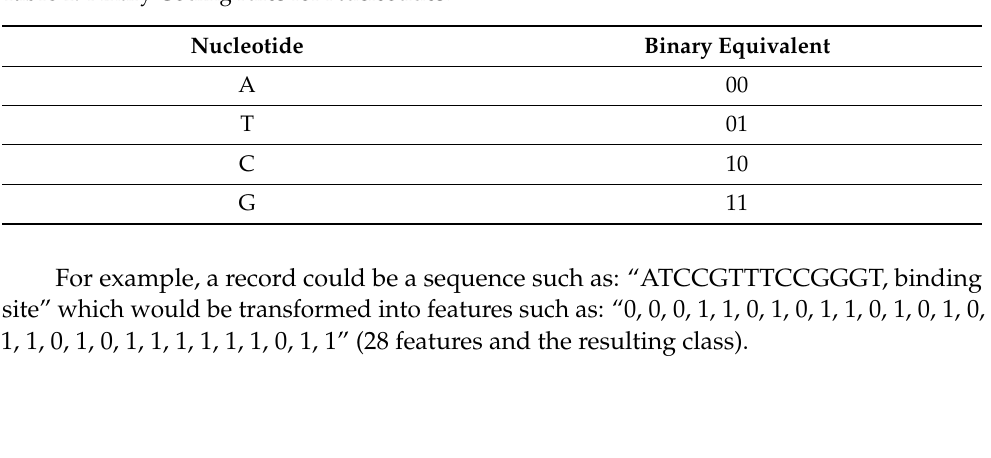
Table 1. Binary Coding rules for